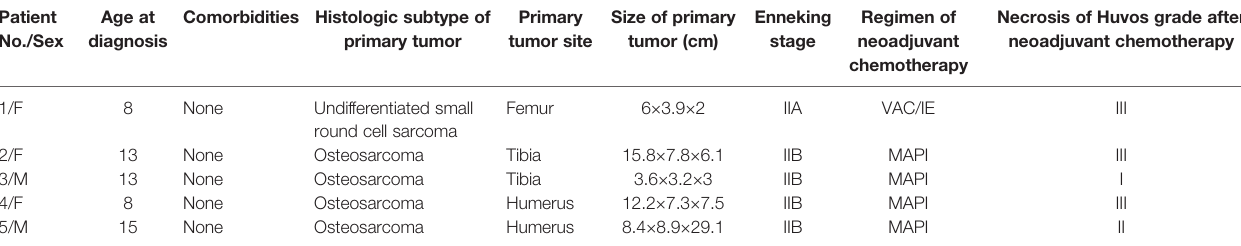
TABLE 1 | Clinical and histological features of primary tumors in bone sarcoma pediatric patients. Patient